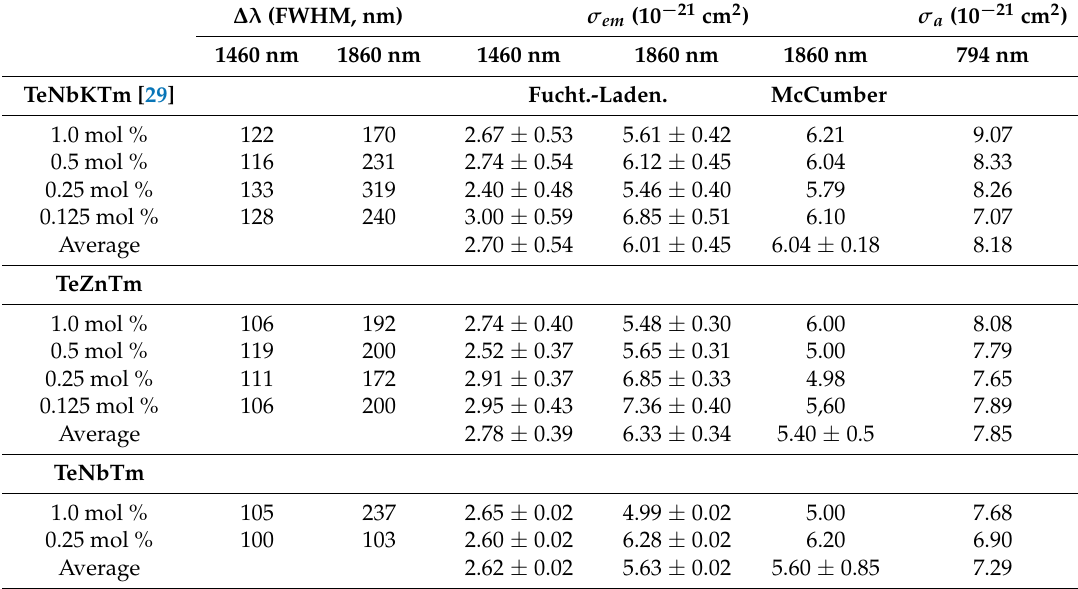
Table 3. Emission cross sections and bandwidths at full-wave half maximum (FWHM) of the 1460-nm and 1860-nm bands, and absorption cross sections at 794 nm for the Tm 3+ :TeO 2 -based glass hosts at different Tm 2 O 3 concentrations.